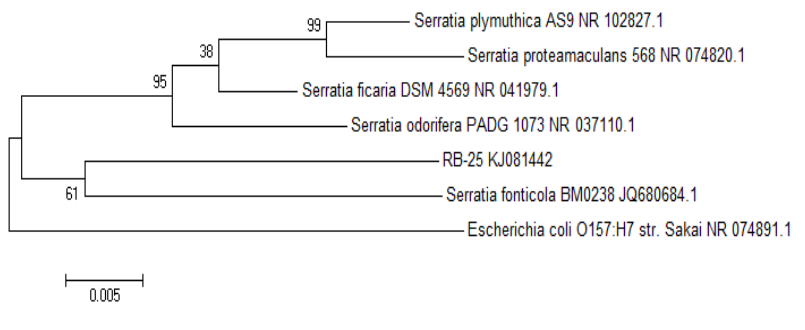
Figure 4. Phylogenetics analysis of strain RB-25.A total of 1,357 positions in the final dataset was used where shown at branches.